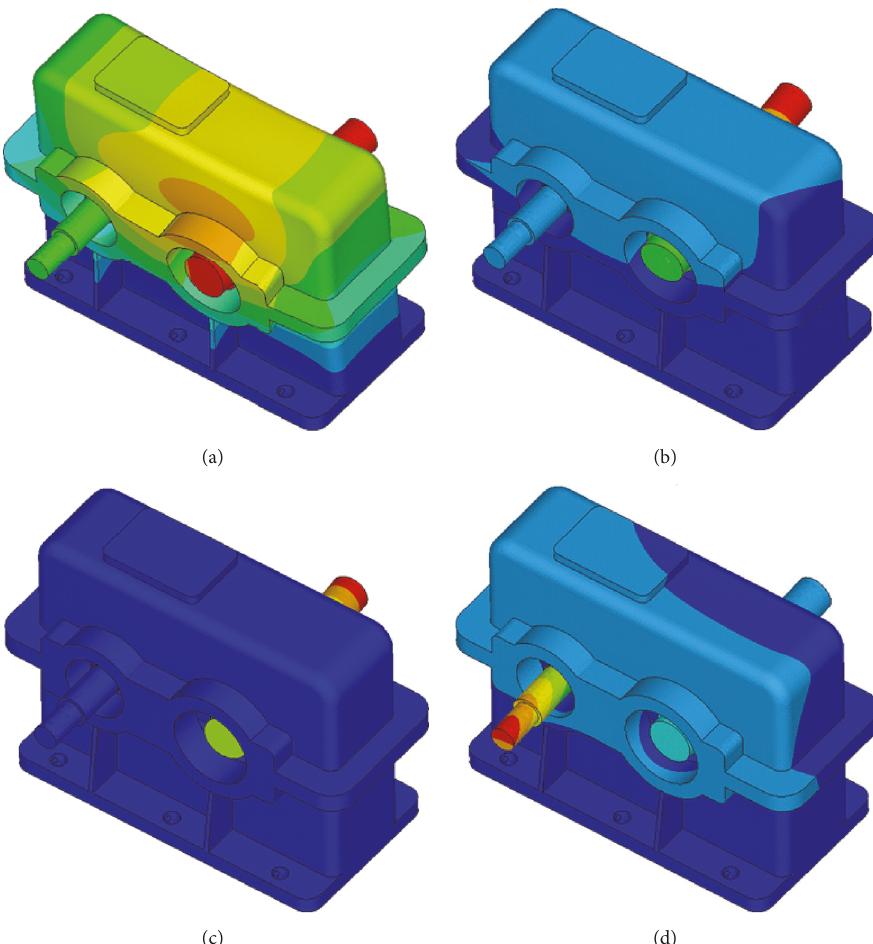
Figure 10: Mode shapes of the whole coupled system: (a) 1st mode; (b) 2nd mode; (c) 3rd mode; (d) 4th mode.